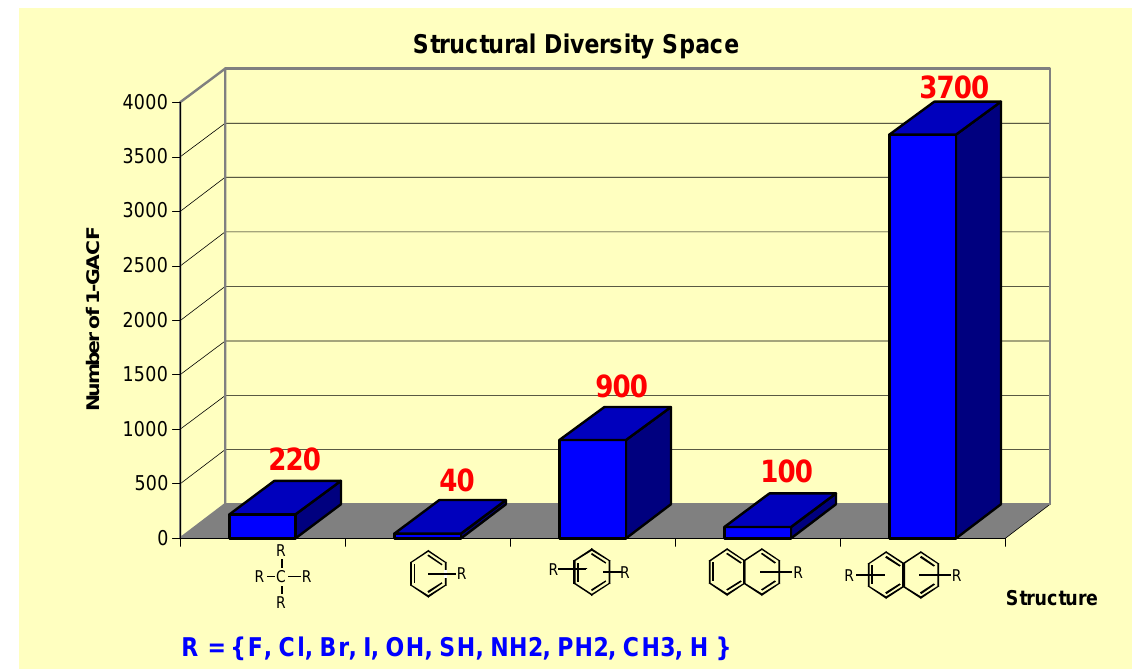
Figure 13. If R is defined as a 10-substitute group, the number of different types of carbon atoms is 220 (1-GACF substructures), for mono-substituted benzene, it is 40 due to symmetry, 900 for disubstituted benzene, etc. This Figure shows that the structural diversity space is a “combinatorial explosion” even if the scaffolds are simple and small.